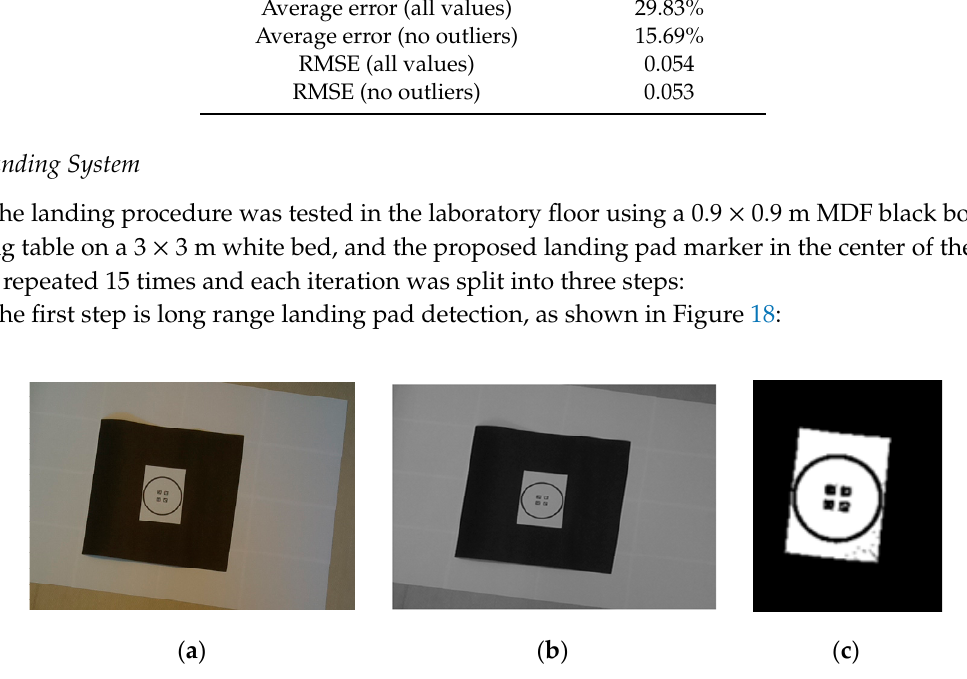
Figure 18. Finding landing table from transversal corridor; from left to right: ( a ) Original image; ( b ) Greyscale modification; ( c ) Binarized.